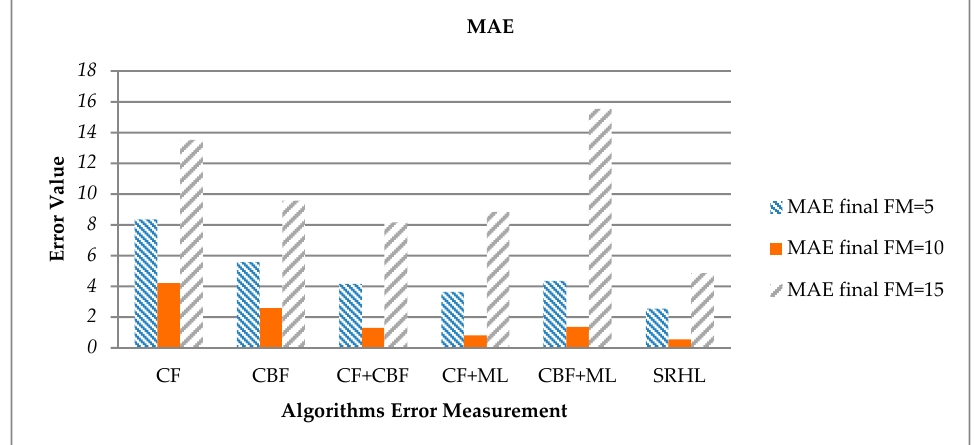
Figure 8. Each experiment’s MAE results. Sensors 2019 , 19 , x FOR PEER REVIEW